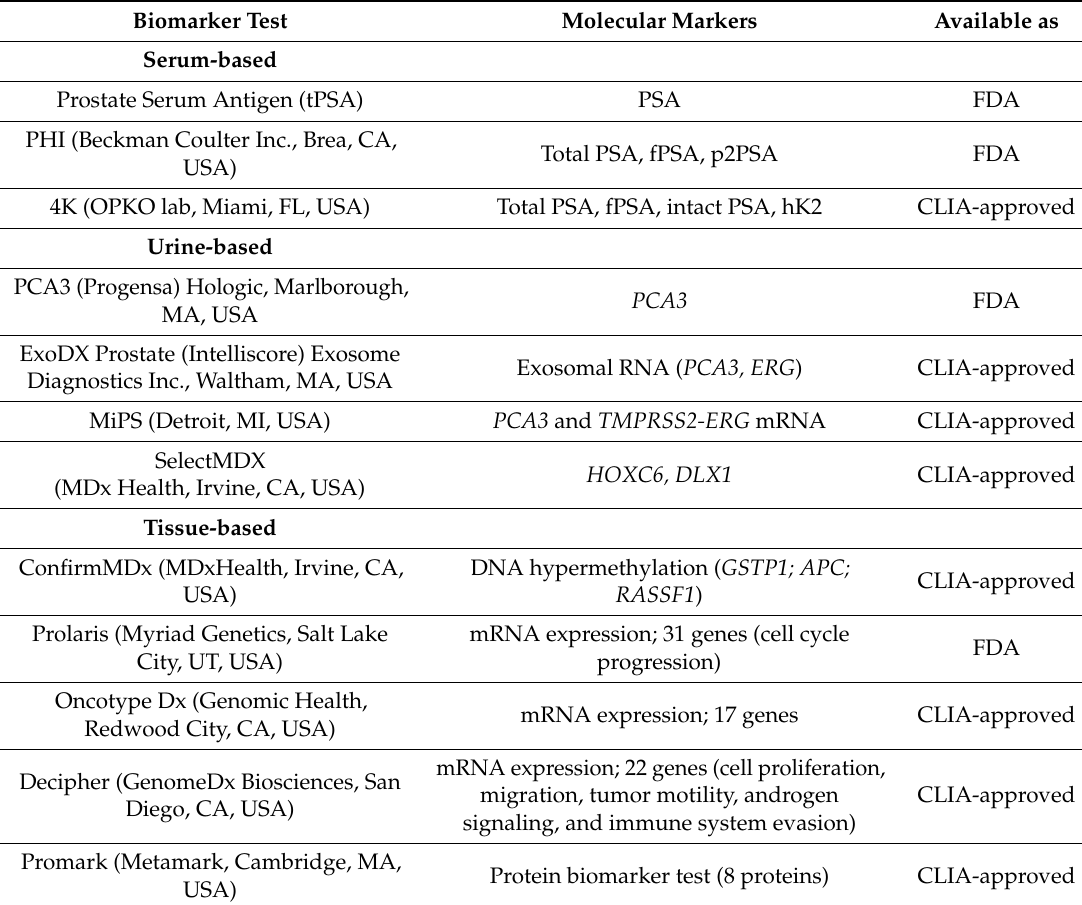
Table 1. Current Food and Drug Administration (FDA) or Clinical Laboratory Improvement Amendments (CLIA) approved blood-, urine-, and tissue-based biomarkers in prostate cancer. Biomarker Test Molecular Markers Available